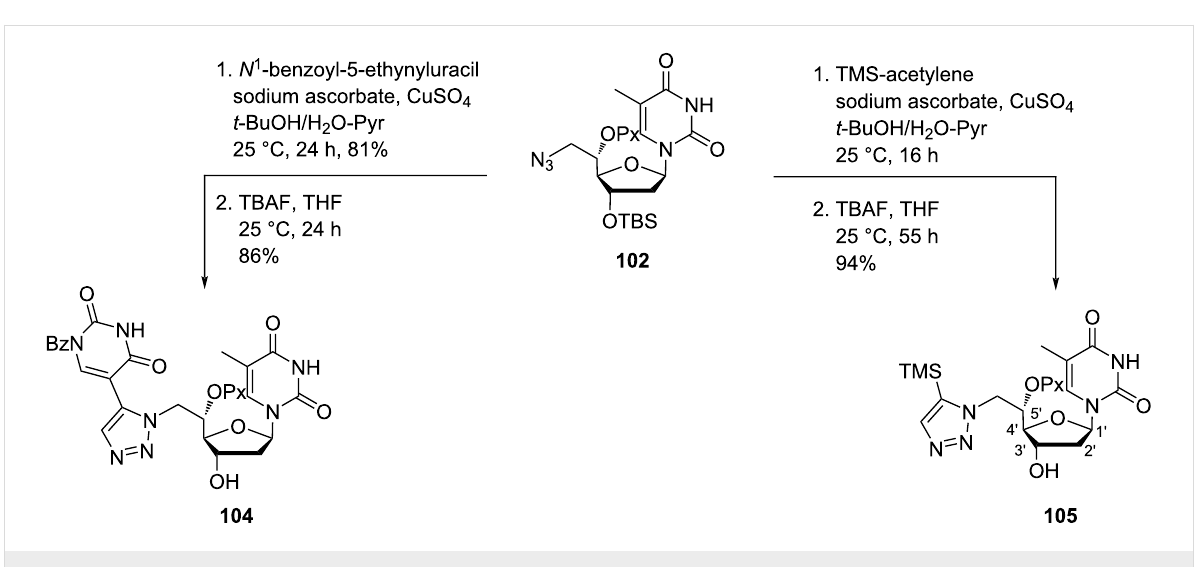
Scheme 23: Double-headed nucleosides 104 and 105 with a triazole